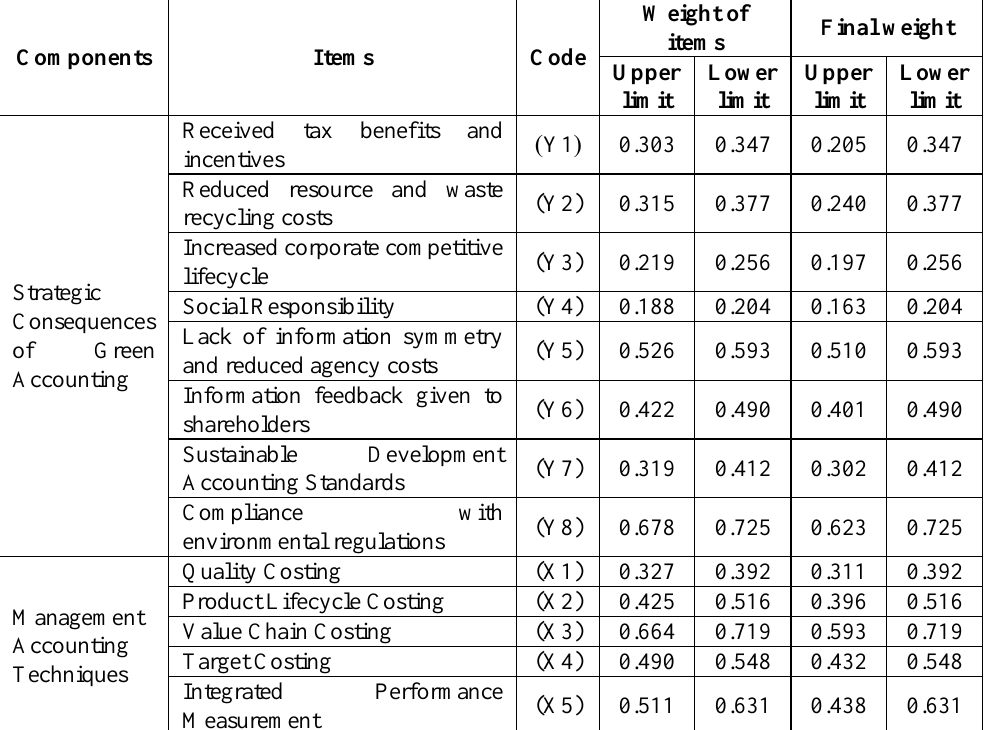
Table 8. Results of the gray hierarchical analysis process